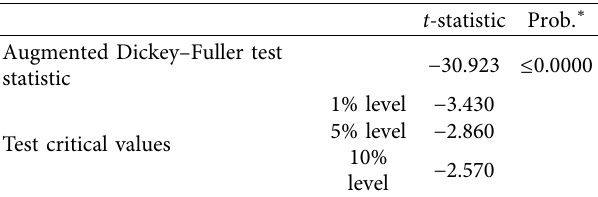
t -statistic Prob.